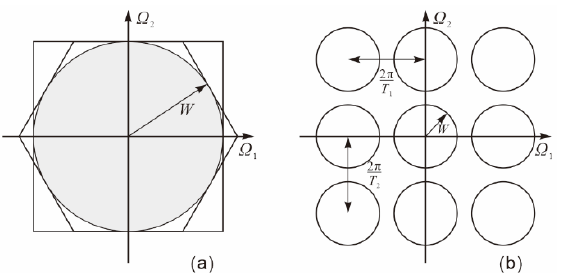
Figure 3. The frequency spectrum of a continuous band-limited signal after passing through a regular quadrilateral sampling grid: ( a ) spectrum of the original continuous signal and ( b ) frequency spectrum of the sampled signal.